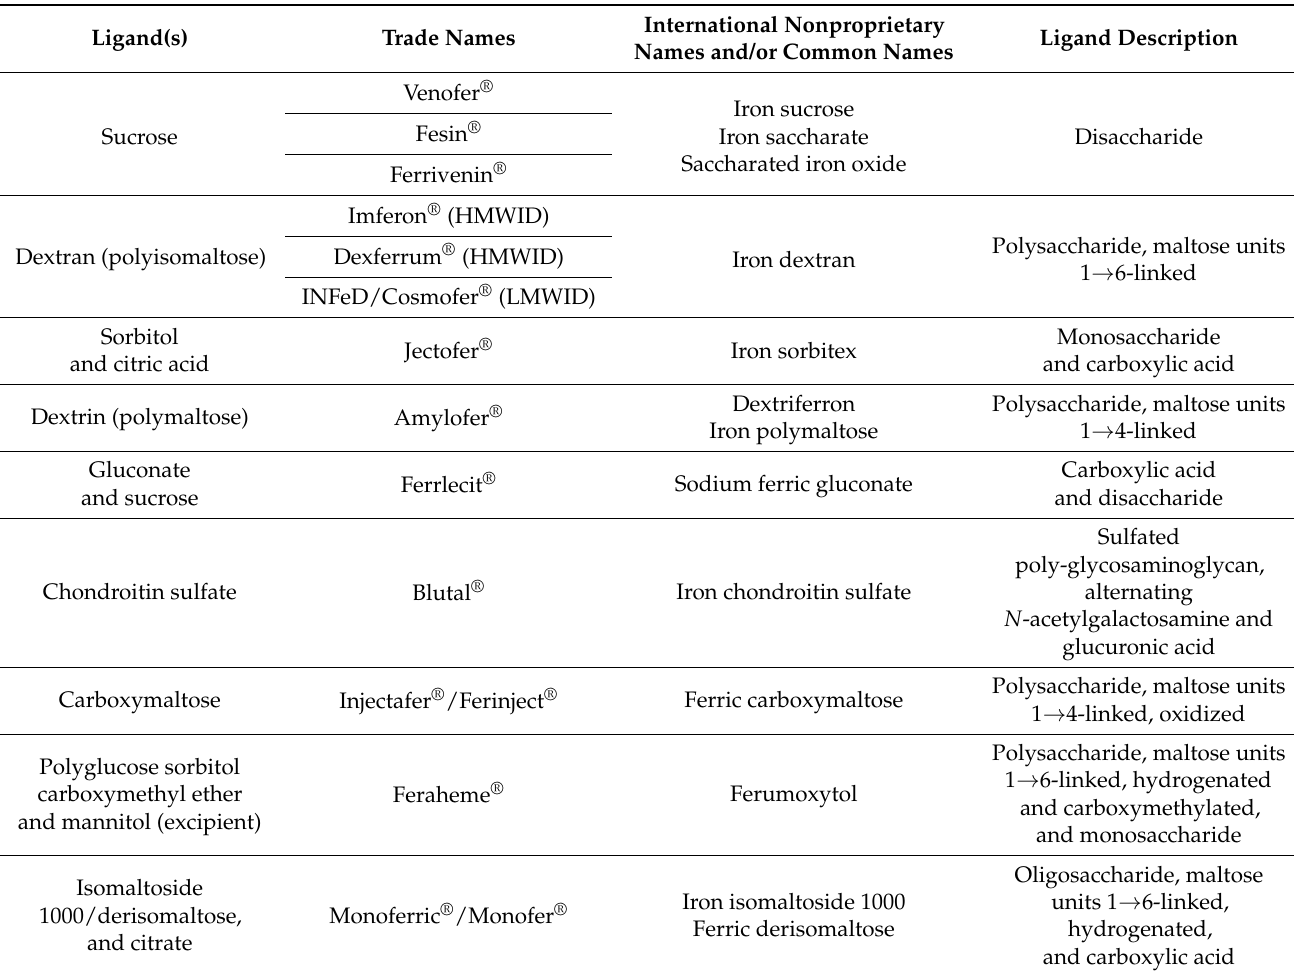
Table 1. Types of ligands used for parenteral iron